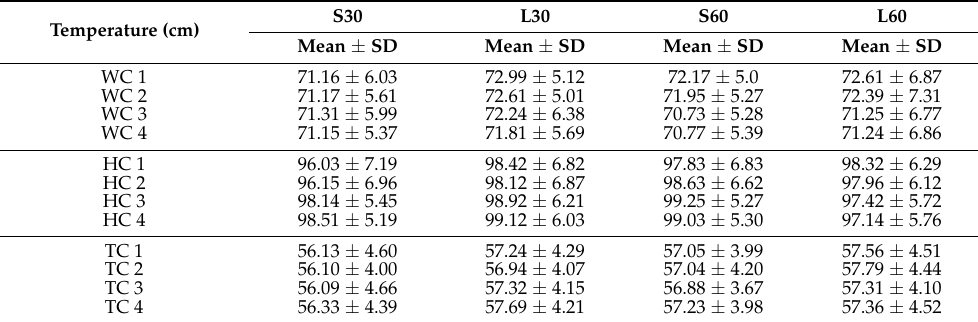
Table 5. Waist-, hip-, and thigh-circumference values measured during consecutive time points during vibration therapy. S30 Temperature (cm)